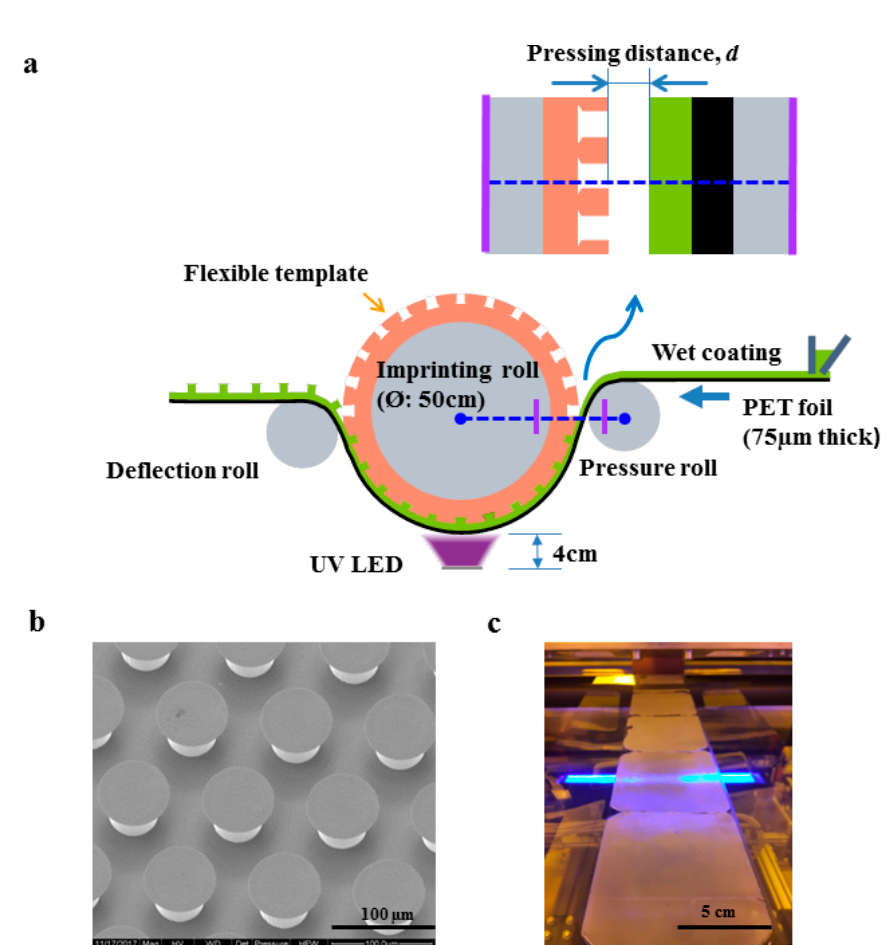
Figure 1. Roll-to-roll fabrication of dry adhesive films. ( a ) Illustration of the imprint unit: The flexible template was glued to the imprinting roll. The wet coating (UA16 prepolymer) on the polyethylene terephthalate (PET) film was pressed into the micropatterned template by means of the pressure roll. The surface-to-surface distance between the wet coating and the template defines the pressing distance, 𝑑 . The position of the deflection roll defines the demolding angle. ( b ) Scanning electron micrographs of the Ni shim surface, providing a positive master structure for template fabrication. ( c ) Photograph of the dry adhesive film made from UA16 upon demolding.